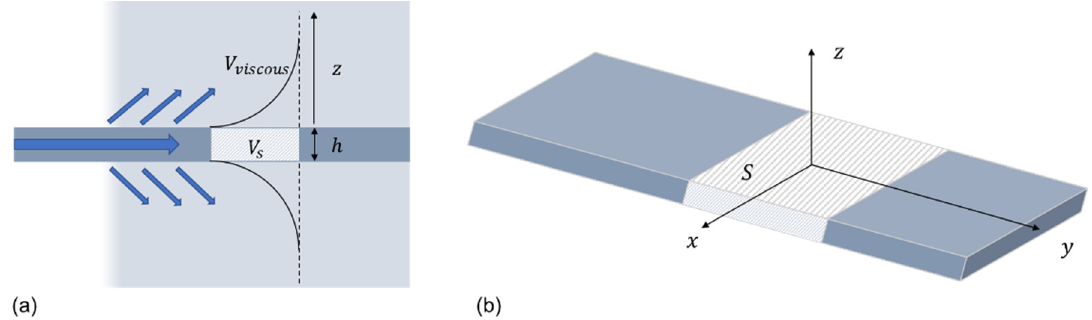
Figure 4. Schematic diagram showing the viscous loading of the surrounding fluid on the waveguide as the SH wave propagates and part of it leaks into the fluid: ( a ) 2D view from the 𝑦– 𝑧 plane; and ( b ) 3D view.